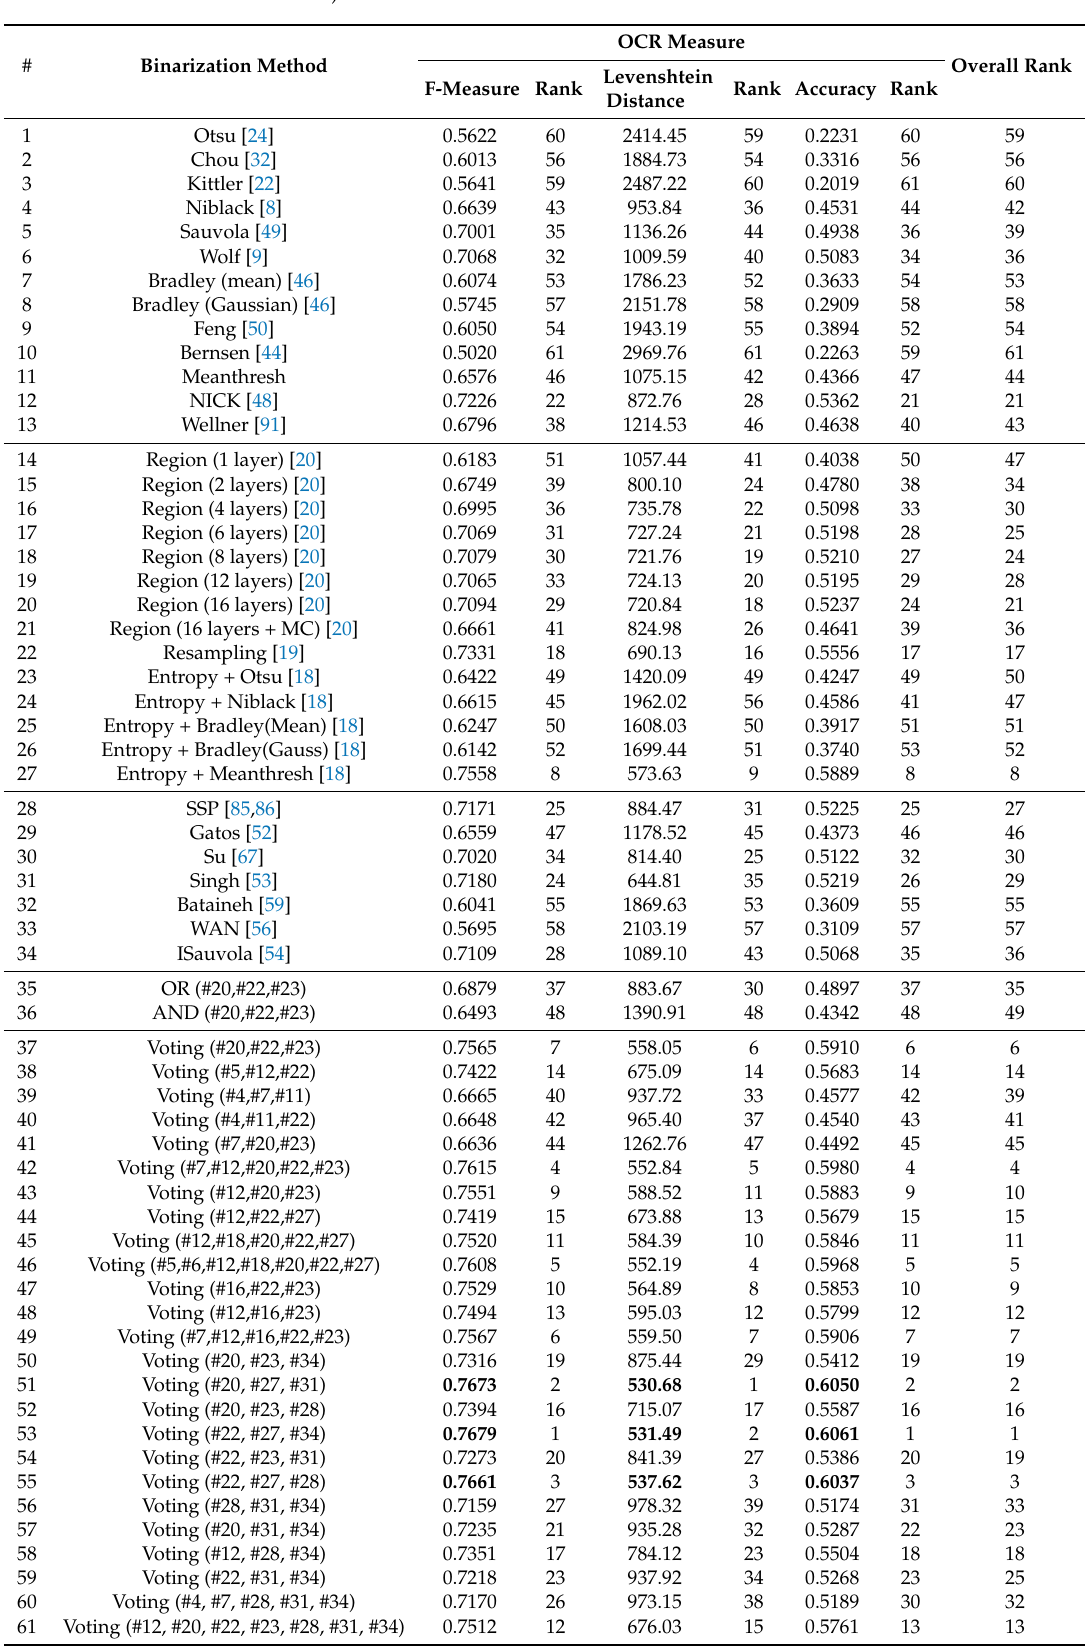
Table 3. Comparison of the average F-measure, Levenshtein distance, and OCR accuracy values obtained for various binarization methods using GNU Ocrad for 176 document images (three best results shown in bold